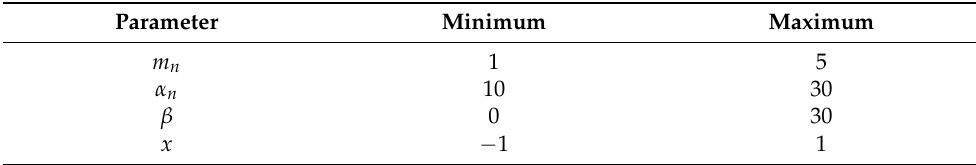
Table 6. The limit values of input design parameters in search